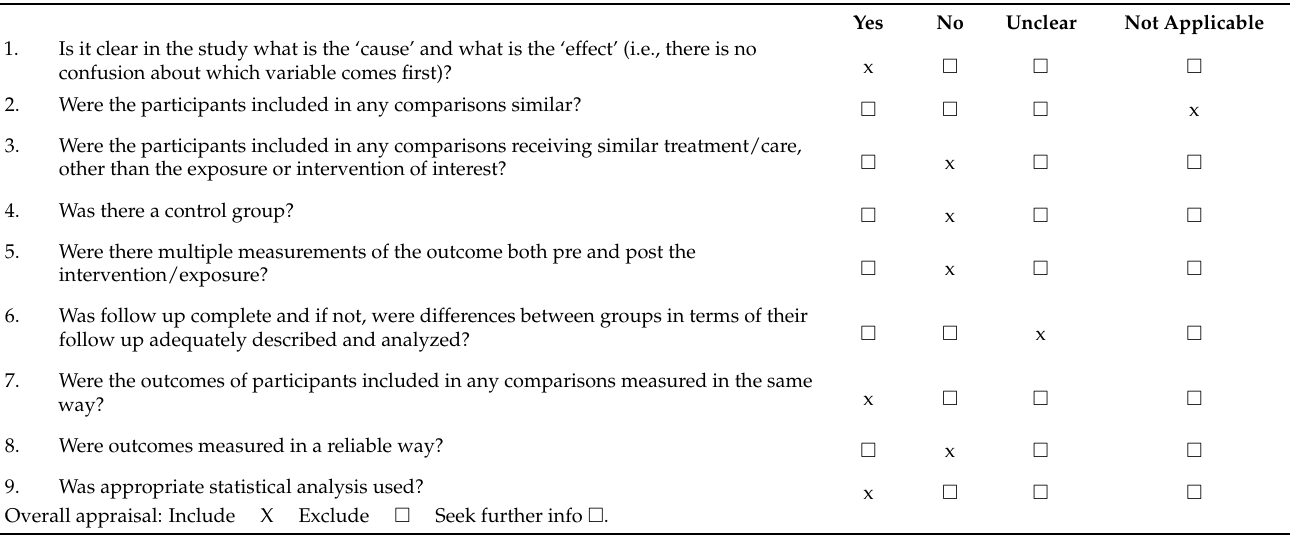
Table A4. JBI Critical Appraisal Checklist for quasi-experimental studies—Ballew (1984) study. Citation: Ballew, C.C. The Effect of High Altitude Hypoxia on Newborn Body Composition in Two Populations in Bolivia. Ph.D. Thesis,